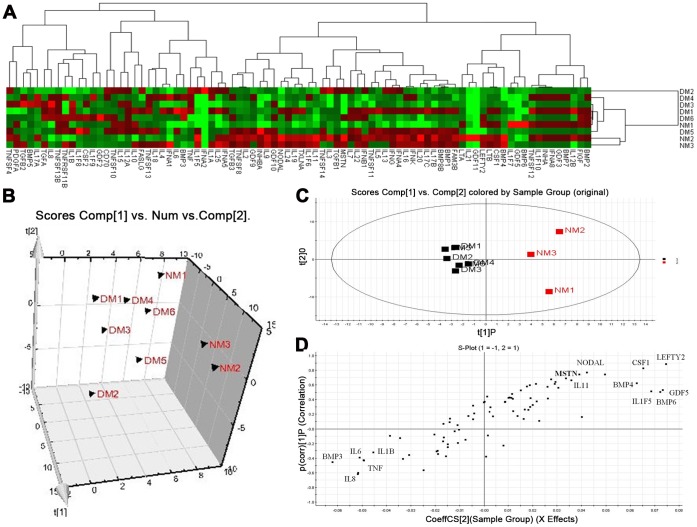
Multivariate analysis of cytokine gene expression profiles from controls (NM1-NM3) and dysmenorrheic (DM1–DM6) samples on the first day of menstruation.A) Heat map showing hierarchical clustering of individual arrays by gene expression. B) 3D PCA score plot showing separate clustering of expression profiles corresponding to DM vs. NM. C) OPLS-DA model results for DM vs NM group. D) S-plot of OPLS-DA model for DM vs. NM group.